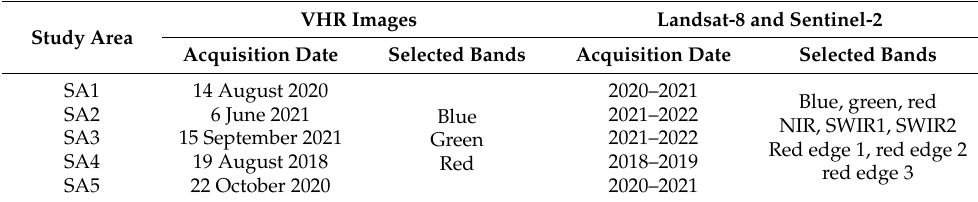
Table 2. Acquisition dates and bands of the images used in this